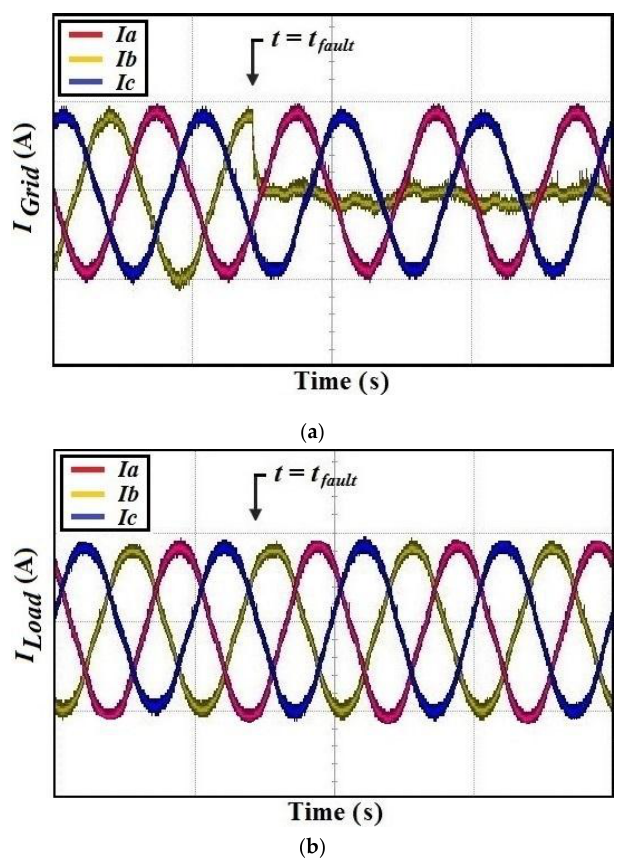
Figure 6. Experimental waveforms of the: ( a ) grid currents ( I Grid ); and ( b ) load currents ( I Load ) with the proposed asymmetrical fault correction technique during a S-L-G fault (X-axis: 20 ms/div; Y-axis: 1 A/div).